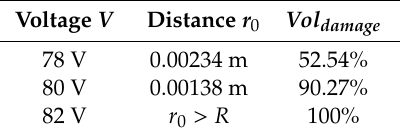
Table 3. The irreversible thermal damage of liposarcoma tumor at t = 150s.